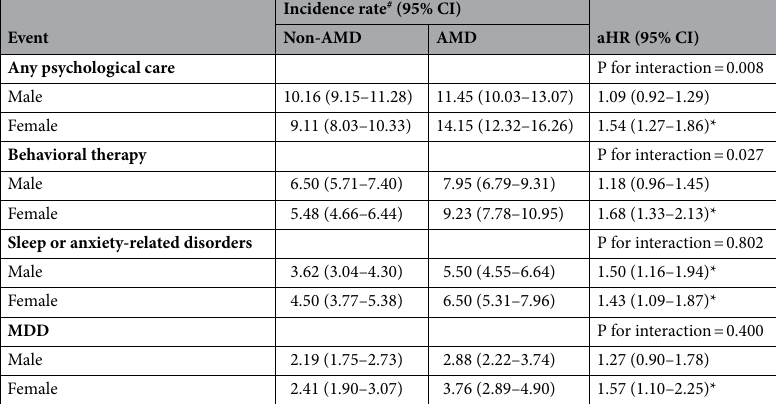
Table 5. Sex stratified hazard ratio for mood disorders in patients with AMD compared with individuals without AMD. AMD age-related macular degeneration, aHR adjusted hazard ratio which adjusted for age, sex, education, marital status, and comorbidities, CI confidential interval, MDD major depression disorder. *Significant result for null hypothesis of aHR = 1. # Crude incidence rate per 10,000